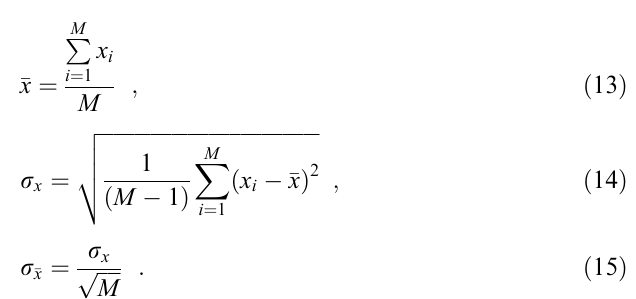
Fig. 9. Distribution and number of occult- ation events for October 20/21, 1995, used for the validation of GPS/MET data based on ECMWF data. The thick solid rectangles denote selected regions of good ECMWF data quality due to dense observational data (European plus USA area), and of degraded ECMWF data quality due to sparse obser- vational data (South Pacific area). For each individual event, the perigee points of the topmost ray ( center of the square symbol ) and of the lowest ray ( plus symbol ) are indicated as taken from the ‘‘occultation tables’’ at the UCAR GPS/MET